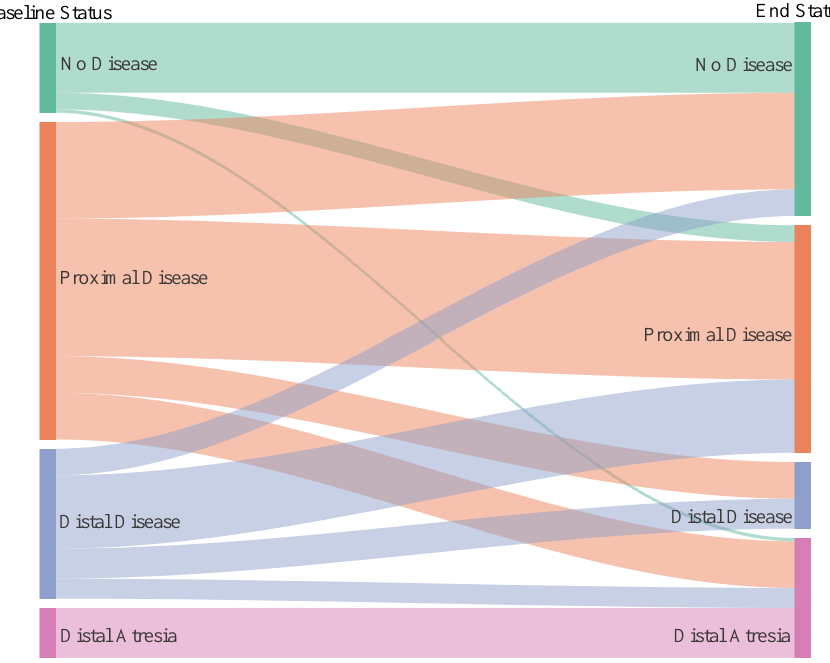
Figure 1. Change in disease status of all pulmonary veins, baseline to study endpoint.